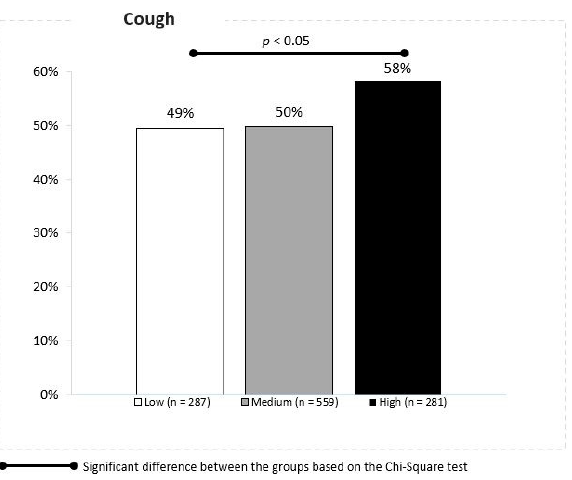
Figure 6. Association between the PM 2.5 concentrations and cough.